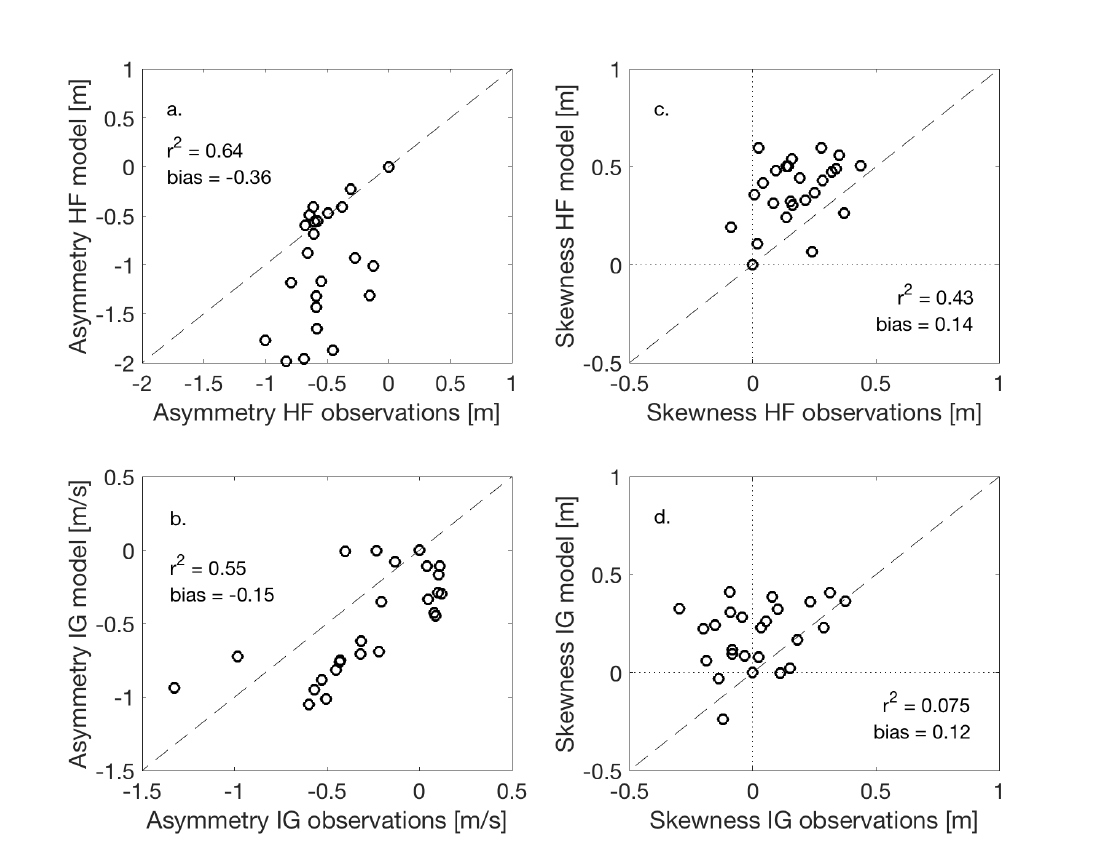
Figure A4. Observed and modeled short (HF, a and c ) and infrgravity (IG, b and d ) wave asymmetry ( a and b ) and skewness ( c and d ) for all four floodings from 1 h before until 1 h after high tide (hourly output) for the first three instrument locations on the North Sea